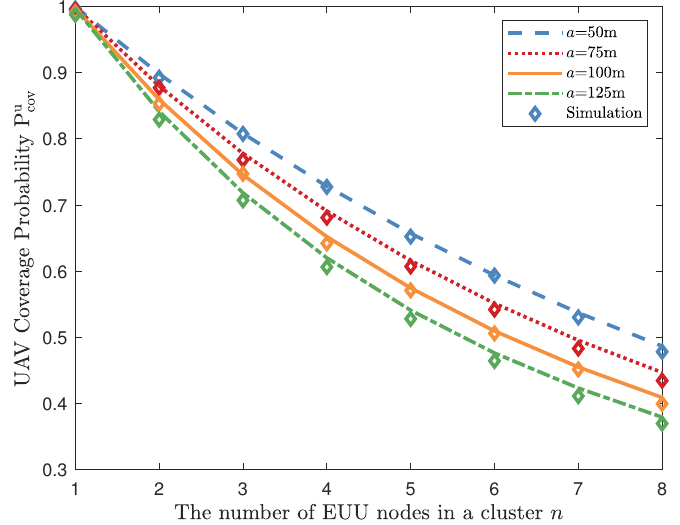
Figure 3. The coverage probability of the UAV versus the number of EUUs within a cluster n with different radius of cluster a , the transmit power of EUUs is 10